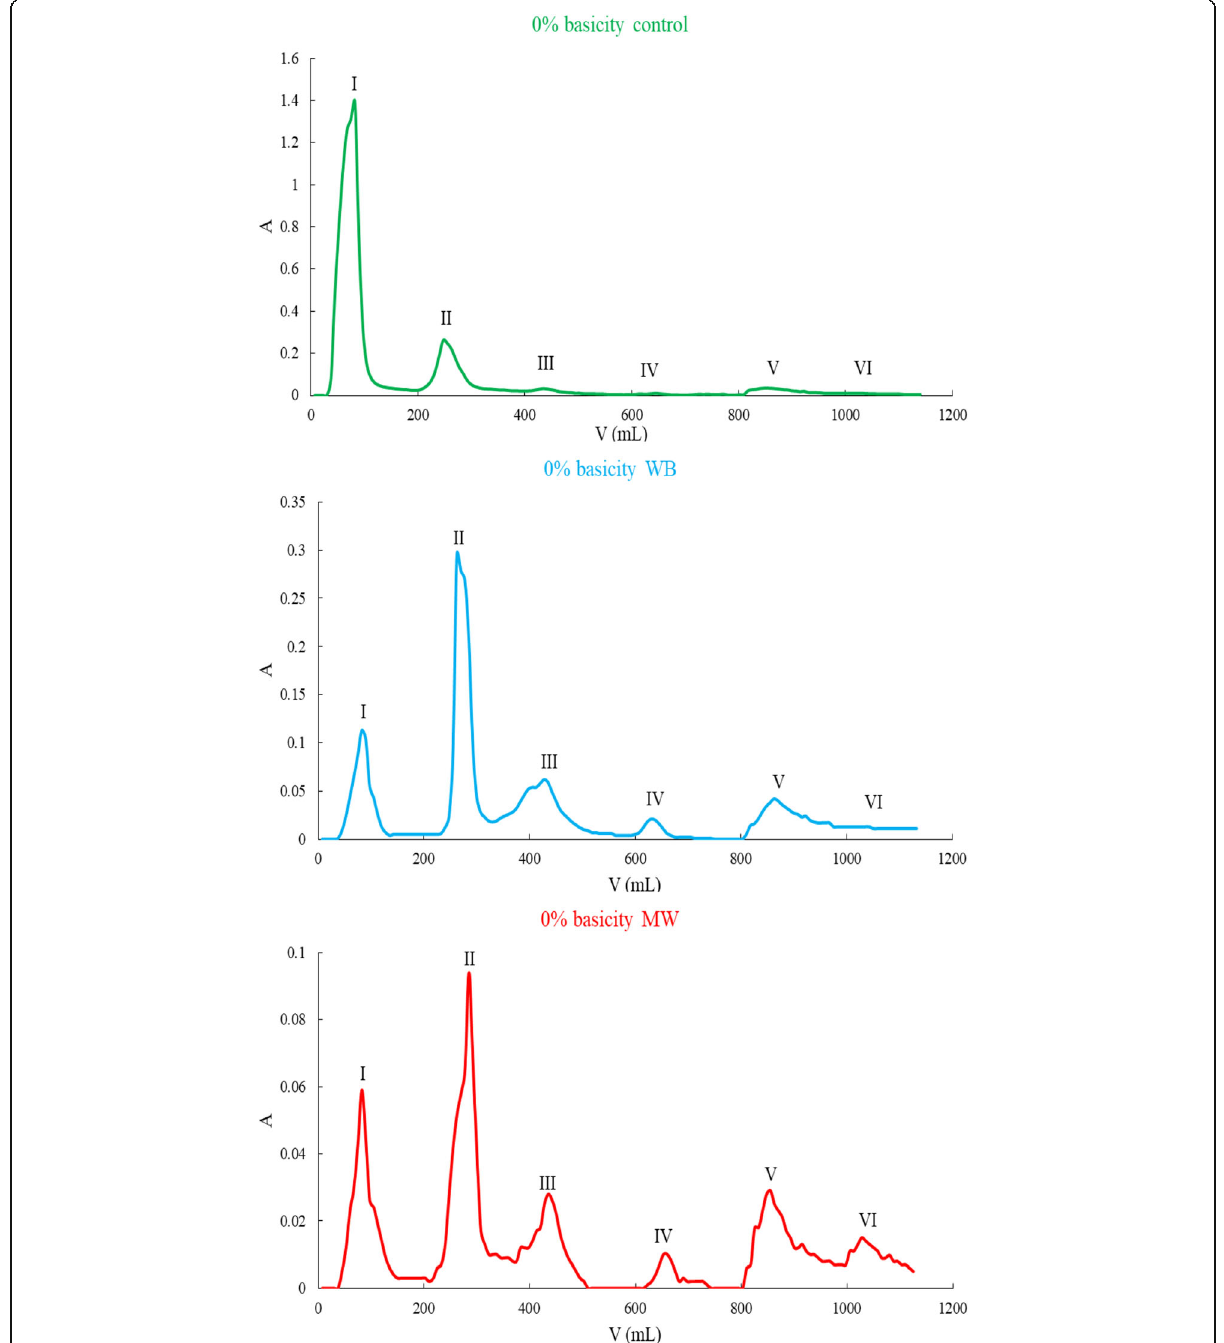
Fig. 1 The IEC results of 0% basicity chromium sulphate tanning liquors warmed under different